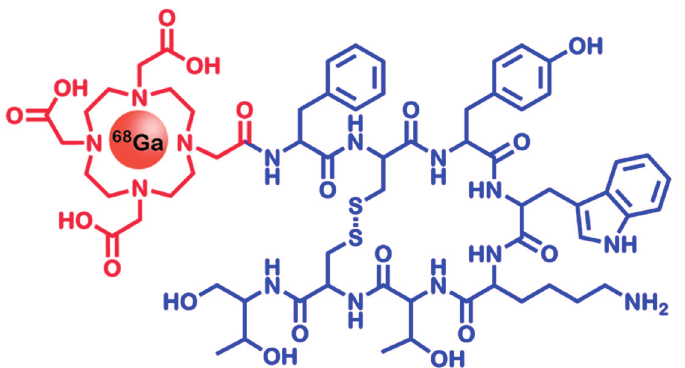
Figure 4. Chemical structure of [ 68 Ga]-DOTATOC (DOTA(0)-Phe(1)-Tyr(3))octreotide). It shows high affinity to SSTR2 (Somatostatin Receptor 2)—a receptor overexpressed in neuroendocrine tumors. The blue portion of the molecule is responsible for the SSTR2 specificity, whereas the radionuclide 68 Ga contained in the chelator DOTA (red) acts as the signal source for PET imaging. For reasons of clarity, chelation bonds are